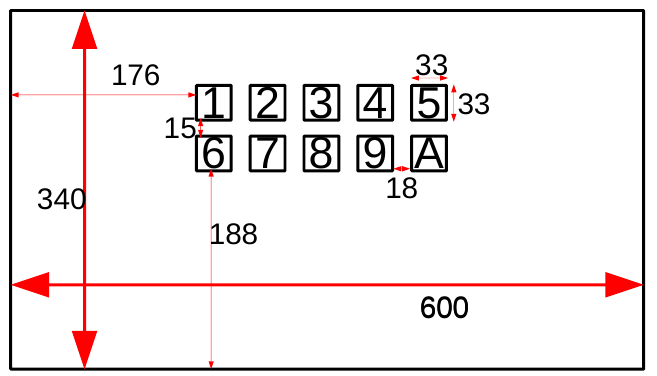
Figure 2. Stimulus presentation: unit, mm; 1: 6.0 Hz, 2: 6.5 Hz, 3: 7.0 Hz, 4: 7.5 Hz, 5: 8.0 Hz, 6: 15 Hz, 7: 16 Hz, 8: 12 Hz, 9: 13 Hz, and A: 14